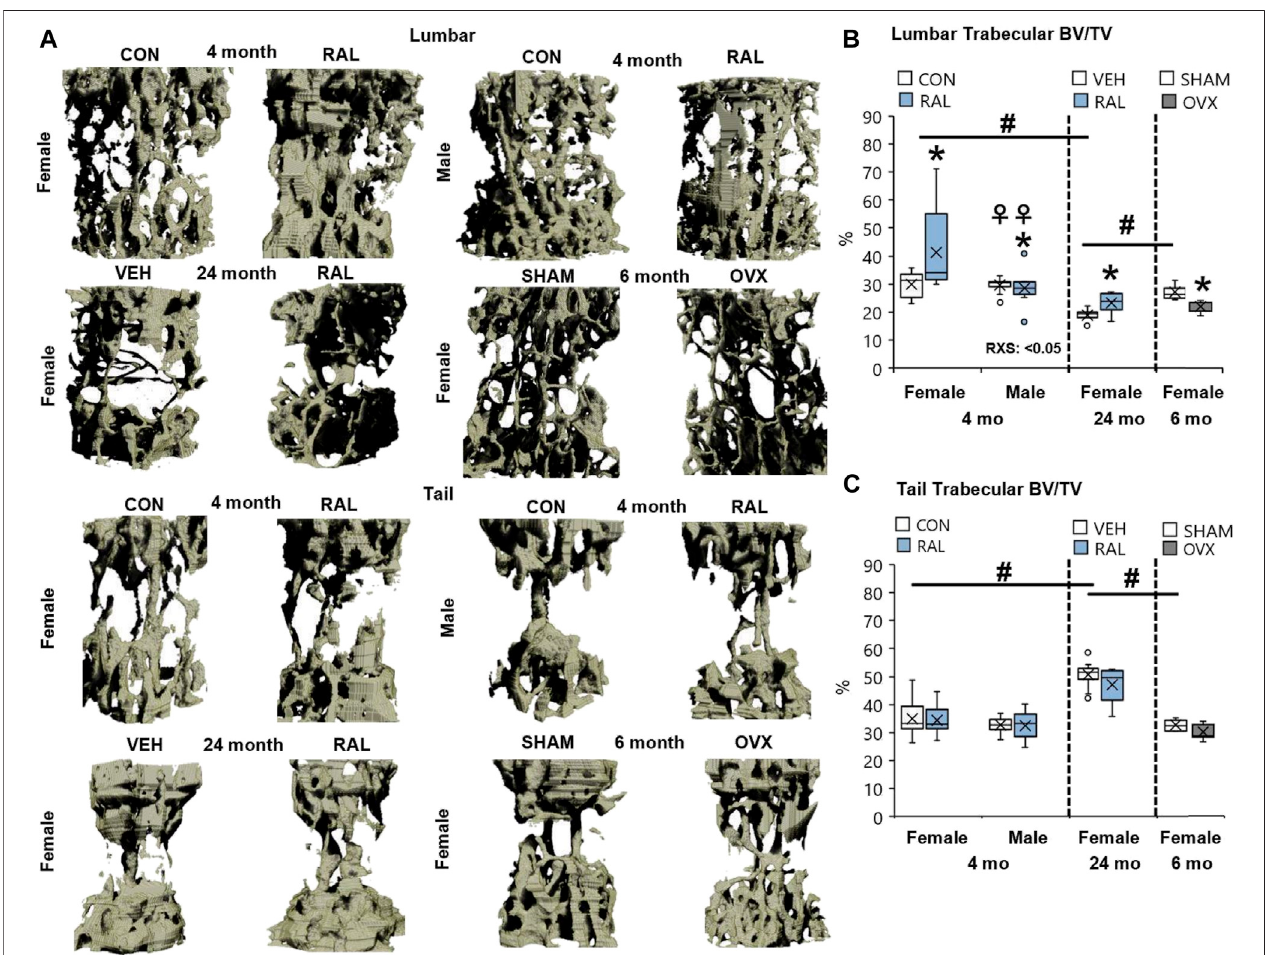
FIGURE 7 | Raloxifene signi fi cantly increased the bone volume lost due to aging in lumbar vertebrae with no change in tail vertebrae. (A) 3D reconstruction of lumbar(L5)andtailvertebra (CC7)fromyoung-adult(4 months),old(24 months),andOVX(6months)mice. (B) Lumbartrabecularbonevolumefraction(BV/TV), (C) tail trabecularbonevolumefraction(BV/TV).Dataarerepresented asboxplotswithmeanmarkedascross(x),25/75%deviationlines,andmaximum/minimumwhiskers.*: Control (CON, n = 5/sex/group) vs. raloxifene (RAL); R: CON vs. RAL; S: male vs. female; RxS: interaction; vehicle (VEH, n = 8/group) vs. RAL, SHAM ( n = 4 – 5/ group) vs. ovariectomized (OVX); # : aging effect (4 months vs. 6 months vs. 24 months); \ : sex effect (male vs. female), p <